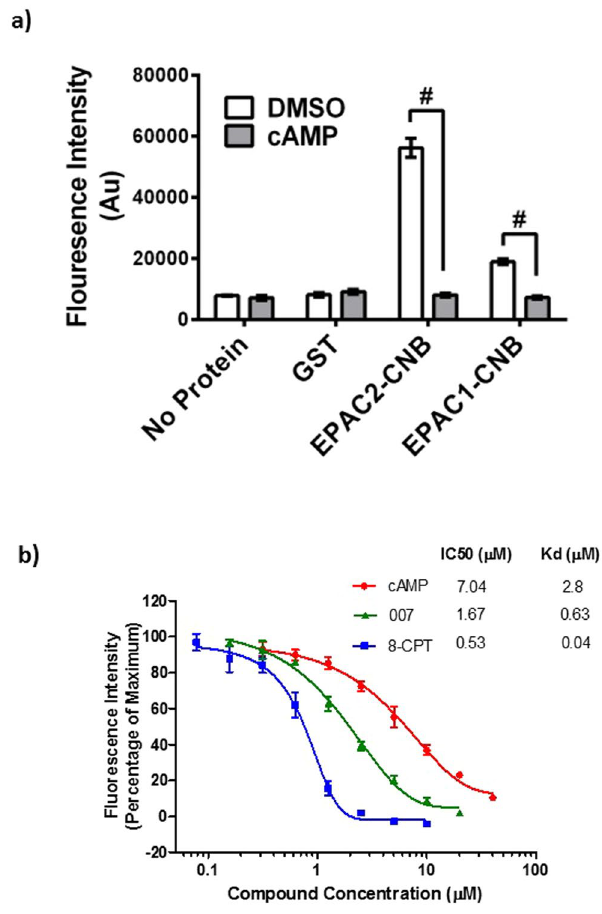
Figure 1. 8-NBD-cAMP Competition Assay Using Purified EPAC1-CNB and EPAC2-CNB Proteins. ( a ) The 8-NBD-cAMP competition assay was carried out as previously described 19 . Briefly, purified EPAC1-CNB (0.8 µ M), EPAC2-CNB (0.8 µ M), GST (0.8 µ M) or assay buffer (no protein) was incubated in the presence of cAMP (50 µ M) or DMSO. 8-NBD-cAMP (0.1 µ M) was then added to every well and the fluorescence intensity was measured after four hours. Significant inhibition of fluorescence in the presence of cAMP is indicated, # P < 0.0001 (n = 3). ( b ) Inhibition of 8-NBD-cAMP (62.5 nM) fluorescence, resulting from interaction with EPAC1-CNB (0.8 µ M), is plotted in the presence of varying concentrations of known competitor compounds; cAMP (red squares), 007 (blue circles) or 8-CPT (green triangles). IC50 values were calculated for each competition assay and are shown in comparison with published Kd values for each